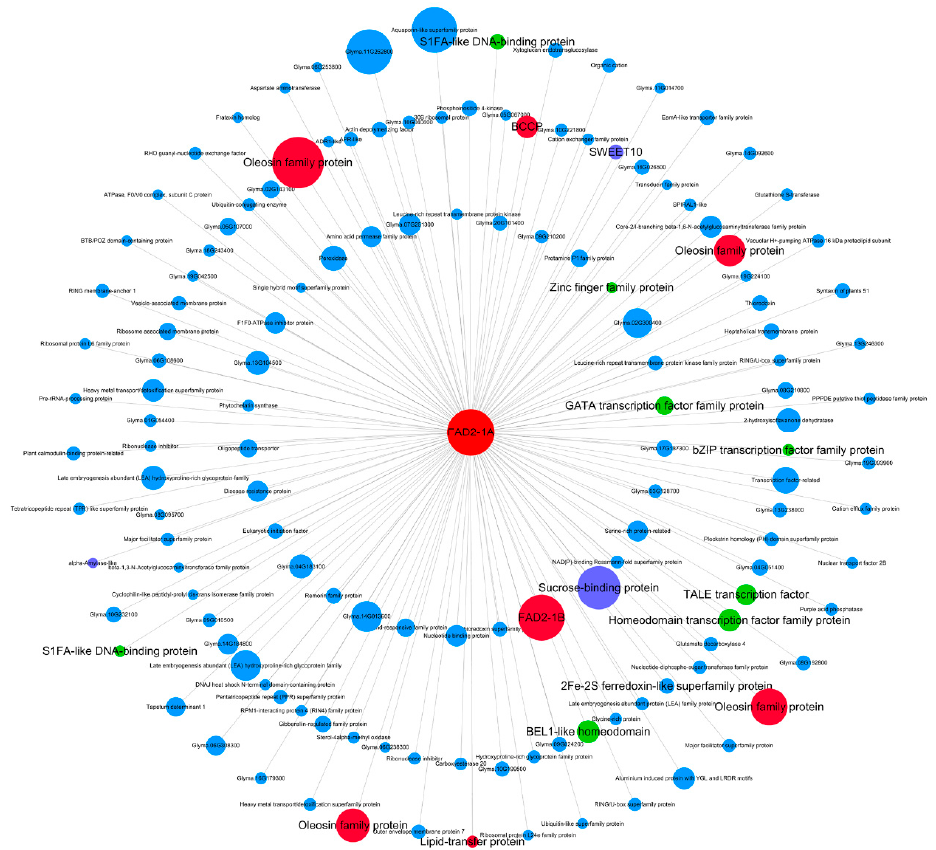
Figure 6. Co-expression network for FAD2-1A ( Glyma.10G27800 ) in the pink module. Only the genes (nodes) with values of gene significance (GS) to oil content, the module membership (MM) to pink module and the gene expression pattern correlation ( r ) with FAD2-1A are all greater than 0.8 are shown. The node size represents the value of log2|Fold change| comparing 20 DAF with 10 DAF. The highlighted red nodes represent lipid metabolism related genes, the green nodes represent transcription factors, the purple nodes represent sucrose and starch metabolism related genes. The innermost genes represent correlation coefficient with FAD2-1A expression greater than 0.95, the middle layer genes represent correlation with FAD2-1A expression between 0.90 and 0.95, and the outer layer genes represents correlation with FAD2-1A between 0.8 and 0.9.